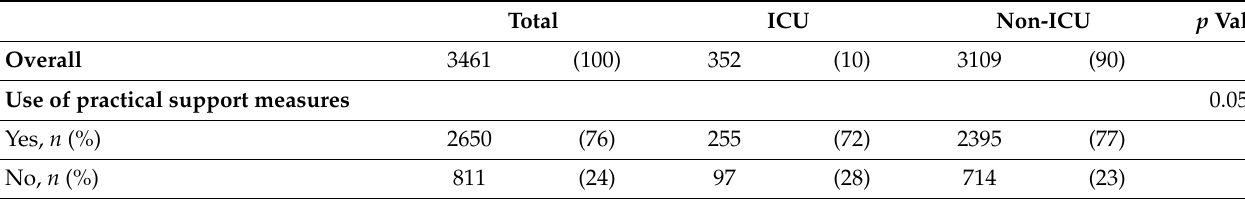
Table 2. Use of practical and mental health support measures by